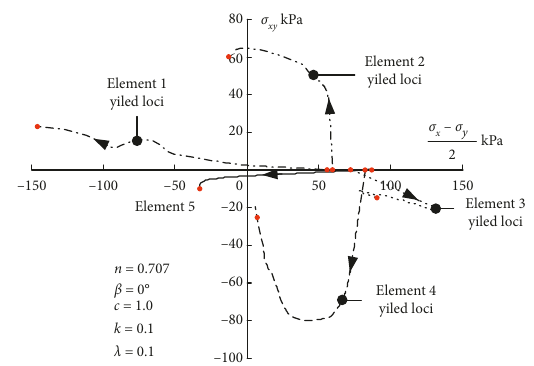
Figure 4: Stress paths in the space of (( σ